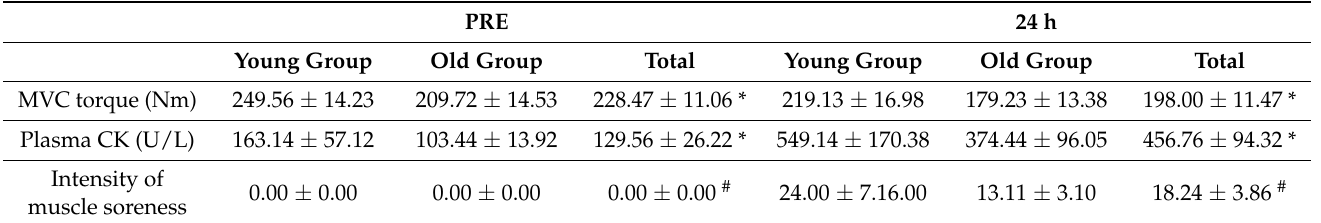
Table 2. Indirect muscle damage markers before and 24 h after the first exercise bout (MEAN ± SEM).